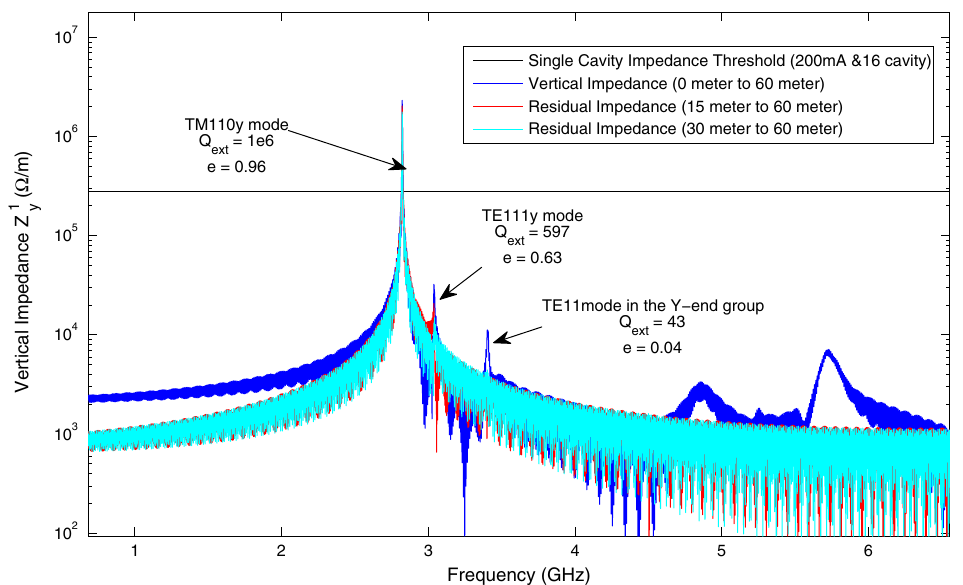
FIG. 13. Single-cavity vertical wake impedances Z 1 Z 60 m 30 (cyan m